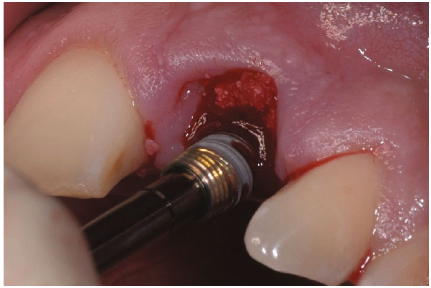
Figure 9: Insertion of the implant in the grafted alveolar socket.